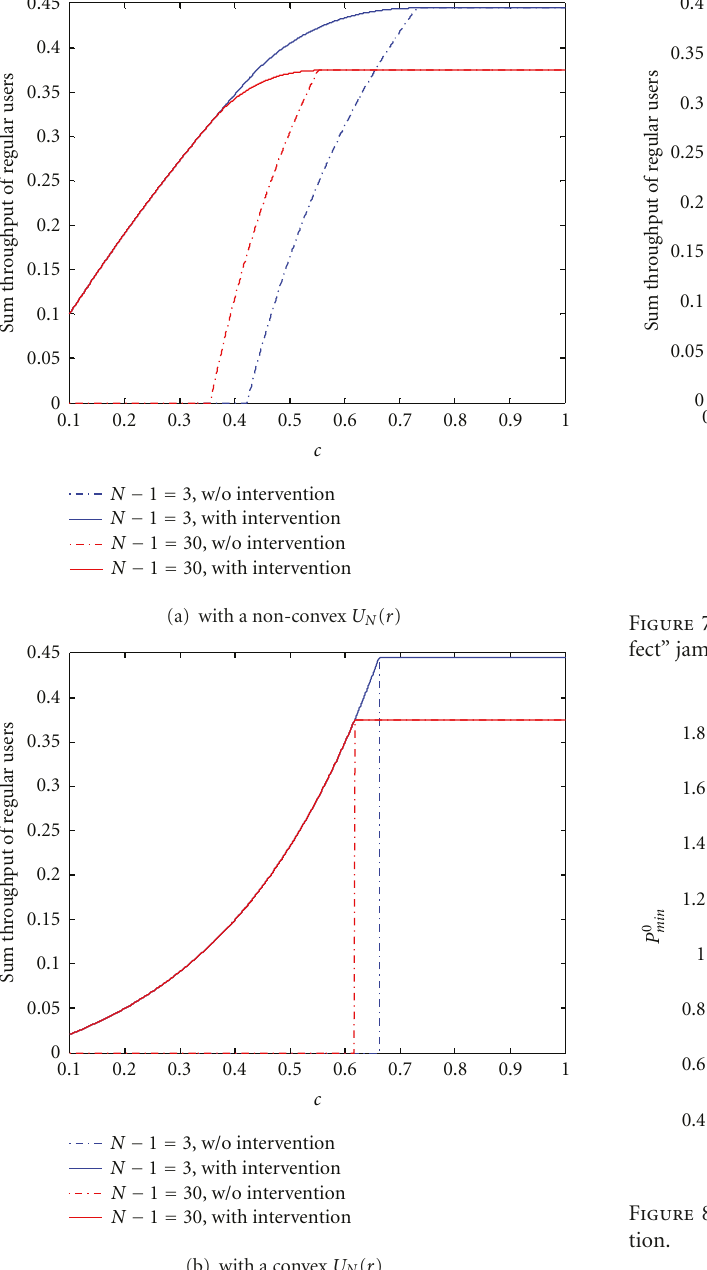
Figure 6: Sum throughput of all the regular users under di ff erent cost c .